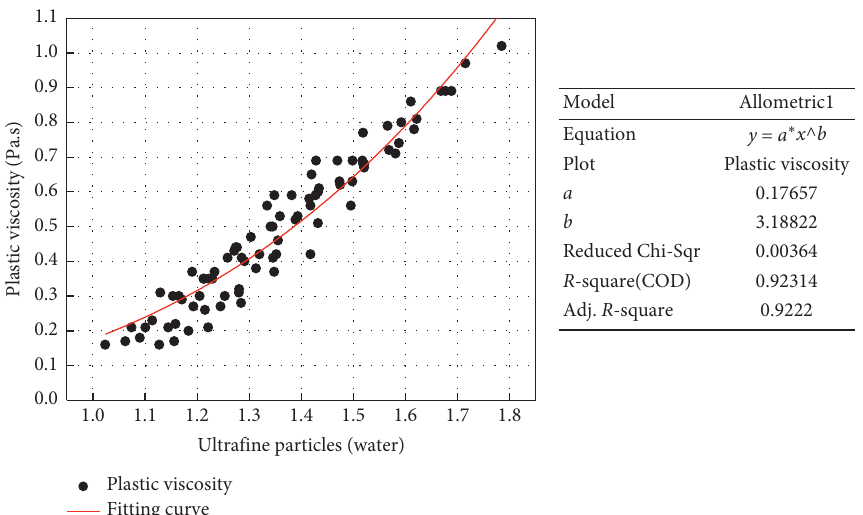
Figure 10: Relationship between the ratio of the mass of the ultrafine particles to the mass of the water and the plastic